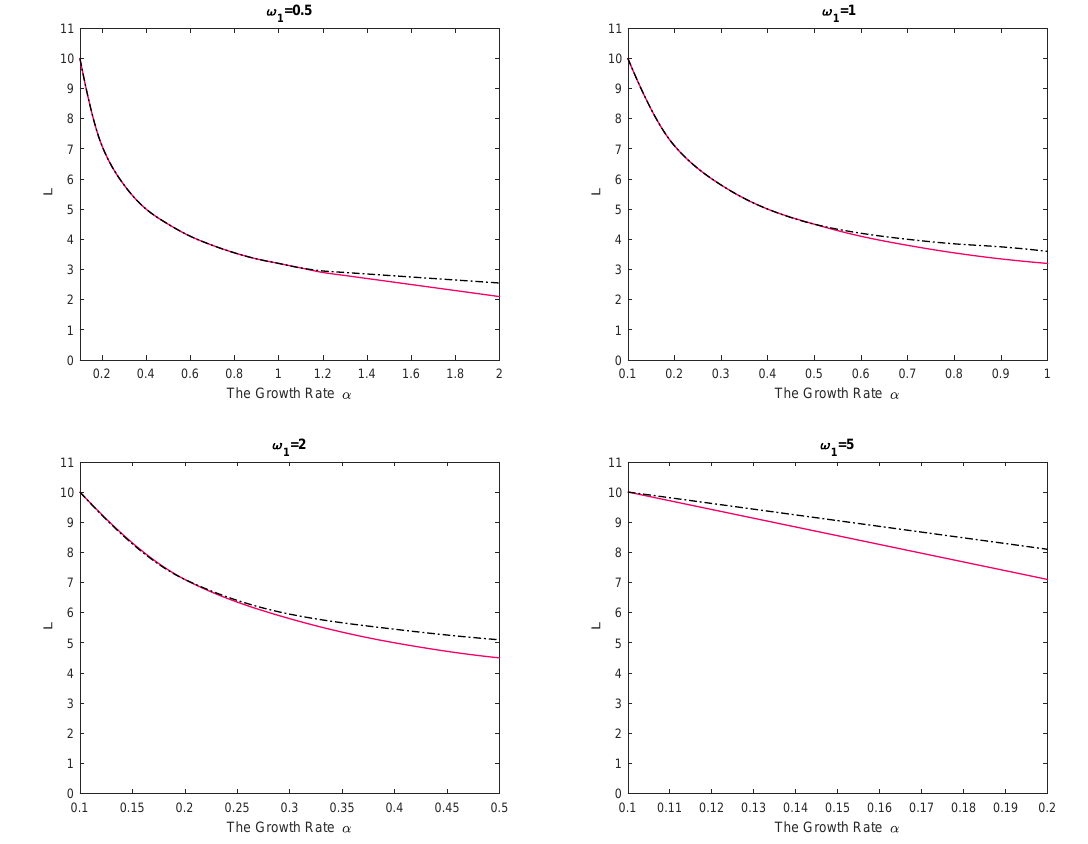
Figure 2. Dependence of the critical domain size on parameter α in case the population growth is logistic (see Equation (30)). The dashed black curve shows the results obtained for the reaction–telegraph Equation (29), and the solid red curve shows the results obtained for the corresponding reaction–diffusion equation, i.e., Equation (29) with ω 1 = 0. Other parameters are K = 1, D =